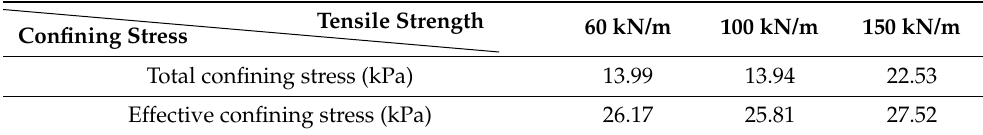
Table 4. Pullout parameters depending on confining